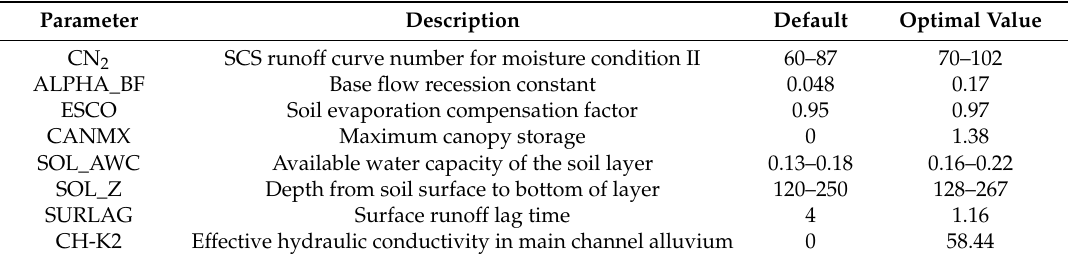
Table 2. Description, default and optimal values used in the model calibration/validation of the SWAT (soil and water assessment tool) model.